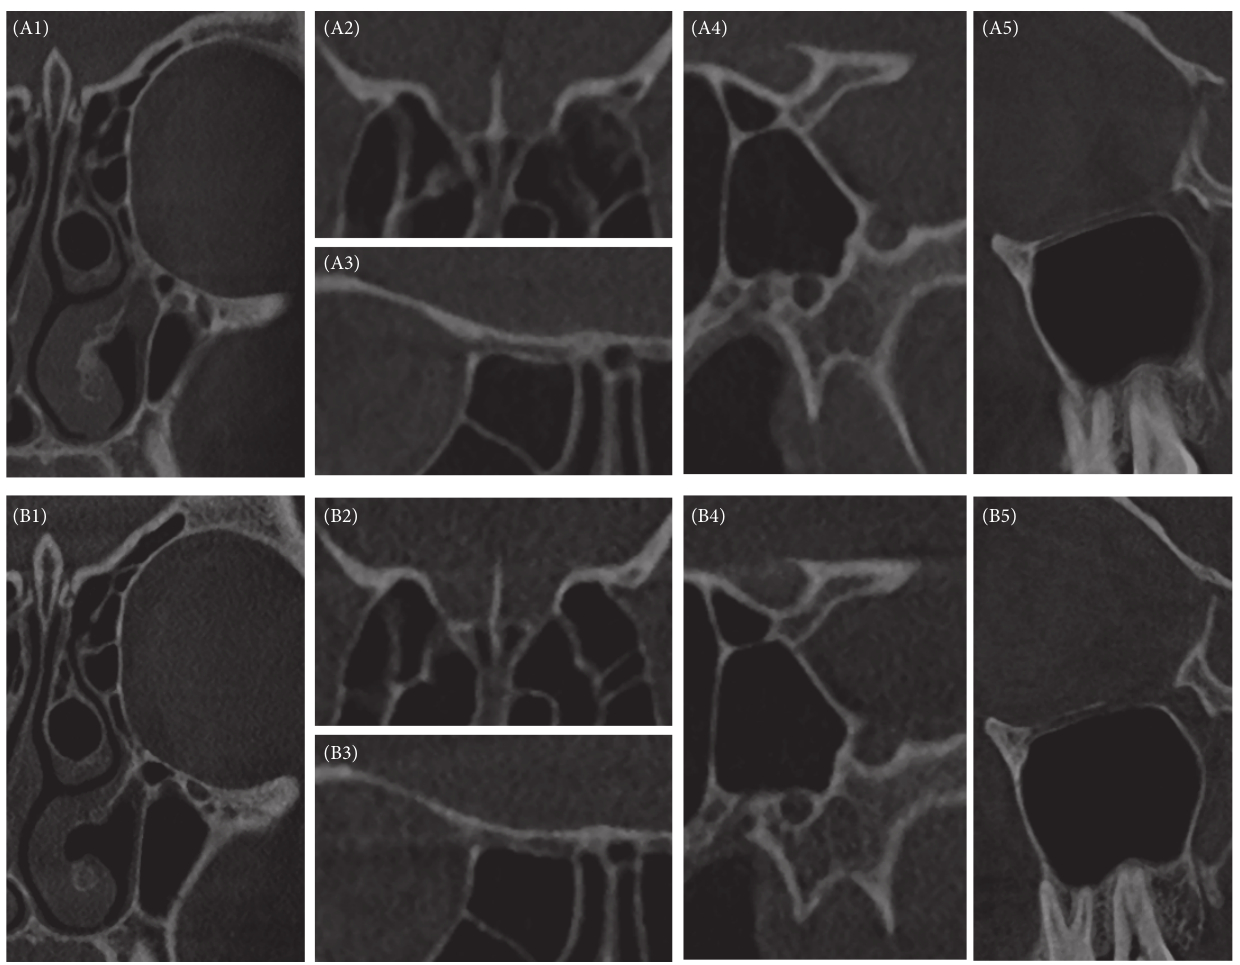
Figure 1: Example of patient examined with both the old (A, group 1) and the new (B, group 2) protocol. Typical images of the anatomical structures are presented to give an impression of the influence of dose reduction (1, os turbinale of inferior turbinate and lamina papyracea; 2, olfactory fossa and anterior ethmoidal artery; 3, posterior ethmoidal artery; 4, optical nerve canal, maxillary neve canal, and vidian nerve canal; 5, infraorbital nerve